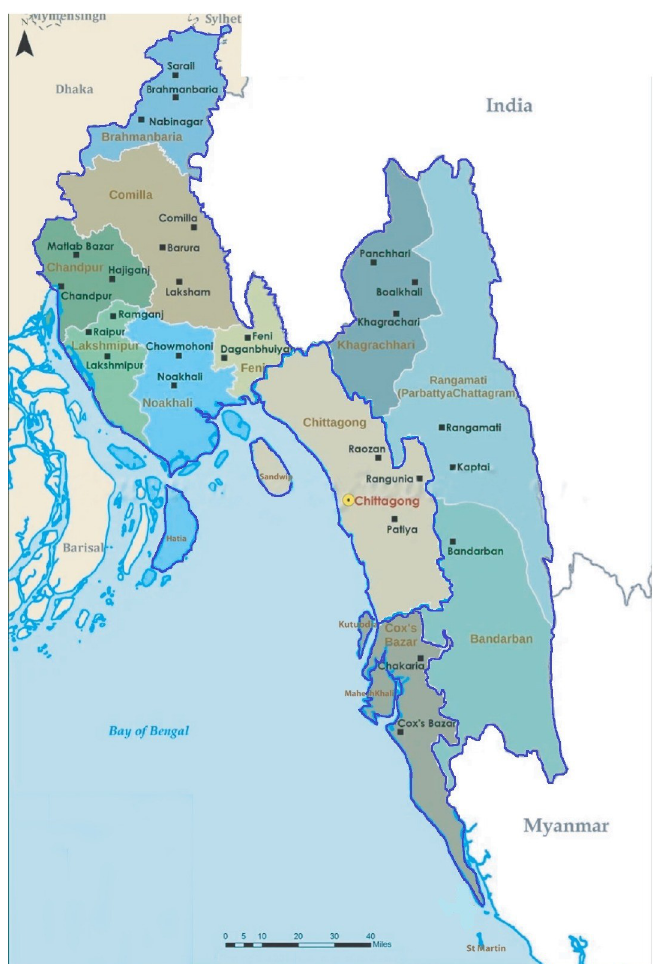
Fig 1. Map of Chattogram